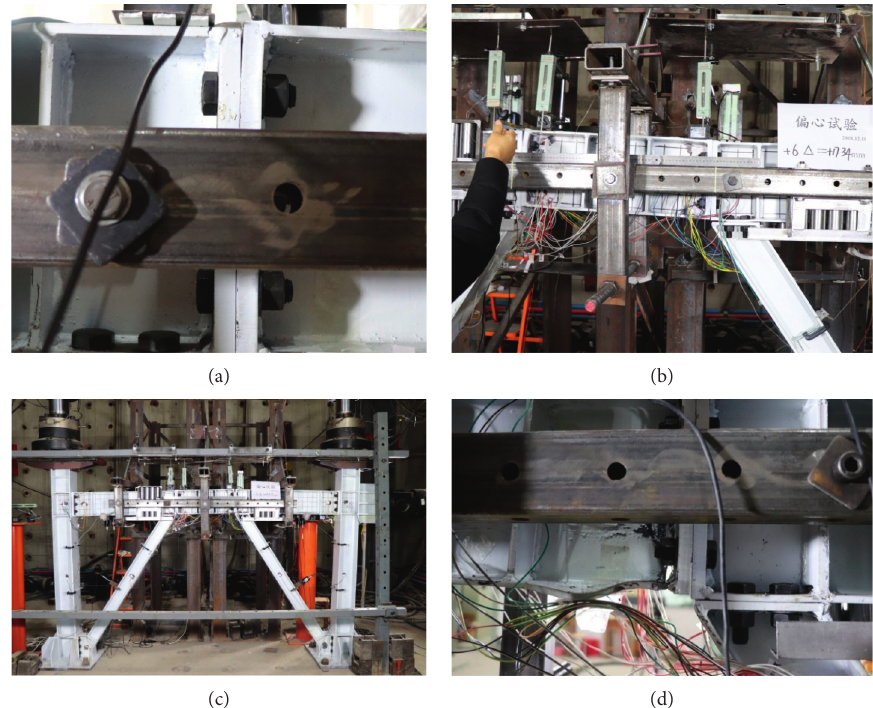
Figure 13: Experimental phenomena of specimen PDKB-2. (a) Deformation at 3 δ (d) Deformation at 8 δ y .